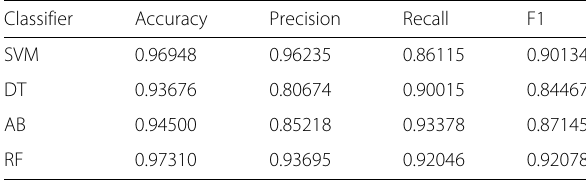
Table 4 Test results of the four